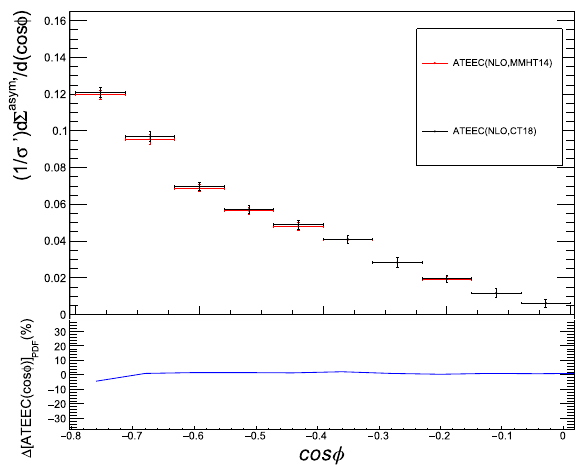
√ s = 314 GeV at HERA. The two input PDFs are indicated energy on the upper frames. The lower frames show (cid:11) [ TEEC ( cos φ) ] PDF and (cid:11) [ ATEEC ( cos φ) ] PDF , defined in Eq. (15)